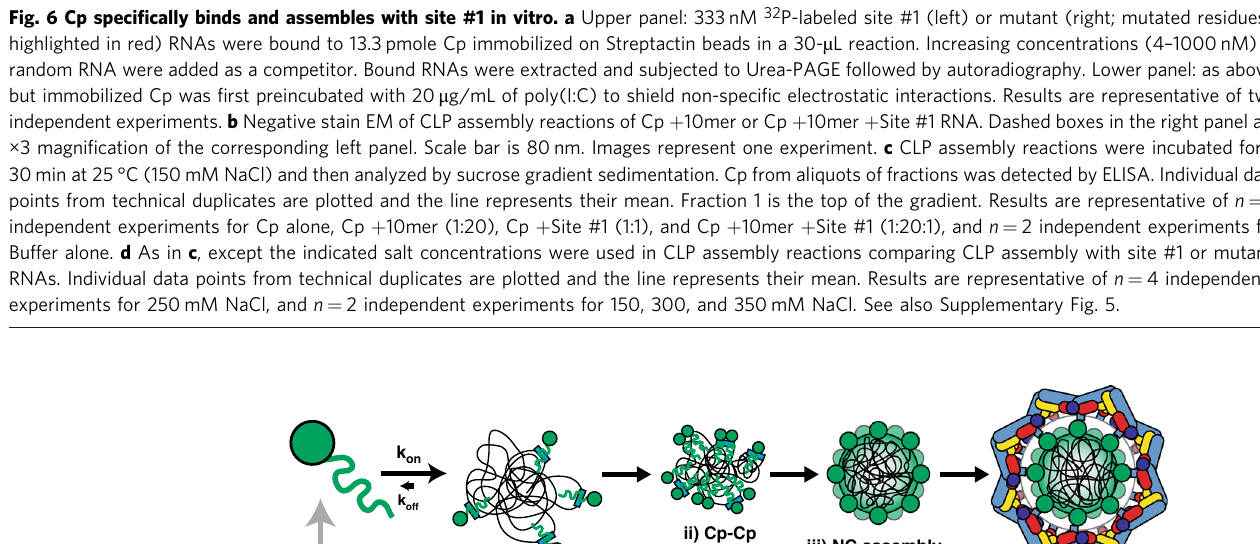
Fig. 7 A multi-site genome packaging model for alphaviruses. (ia) Cp (green) speci fi cally interacts with high af fi nity sites (blue rectangles) on the gRNA (black lines). Such high af fi nity interactions (low Kd) may facilitate longer dwell times for Cp on the gRNA (slow k off ), resulting in stable binding. (ib) Cp can also non-speci fi cally interact with low af fi nity sites (high Kd) on the gRNA or other RNAs such as the sgRNA or cellular RNAs (not shown), but such low af fi nity interactions may lead to short dwell times for Cp on those RNAs (fast k off ) and less stable binding. (ii) As Cp levels increase in the cell, Cp begins binding multiple high af fi nity sites on the gRNA and stays stably bound (low Kd). This may enable further Cp recruitment, including Cp dimer formation, and lead to Cp – Cp oligomerization and gRNA compaction. (iii) NC assembly is completed, resulting in 1 copy of the gRNA surrounded by a shell comprised of 240 copies of Cp arranged with icosahedral symmetry. (iv) Virus assembly and budding occur at the plasma membrane where Cp directly binds the cytoplasmic domain of the E2 envelope protein (coloring as in Fig. 5a). Virus assembly and budding cause discrete changes in Cp:gRNA interactions within the viral